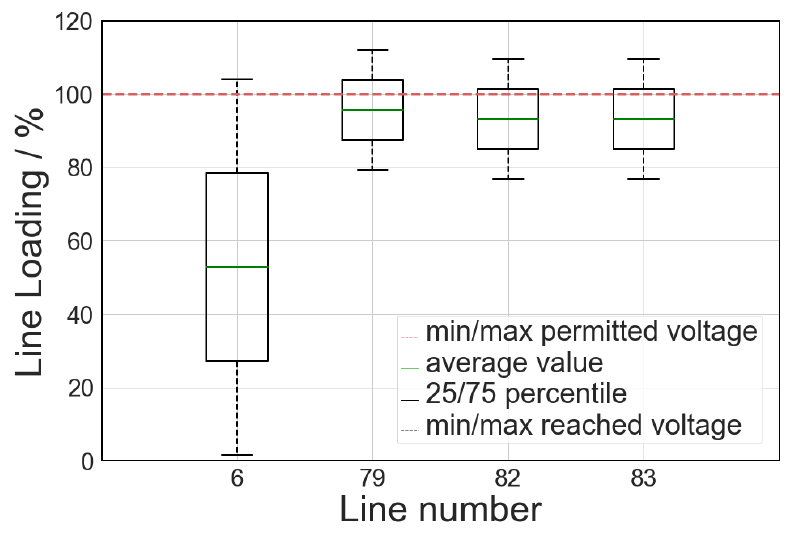
Figure 6. Line loading on some lines of the MV grid before grid reinforcement.